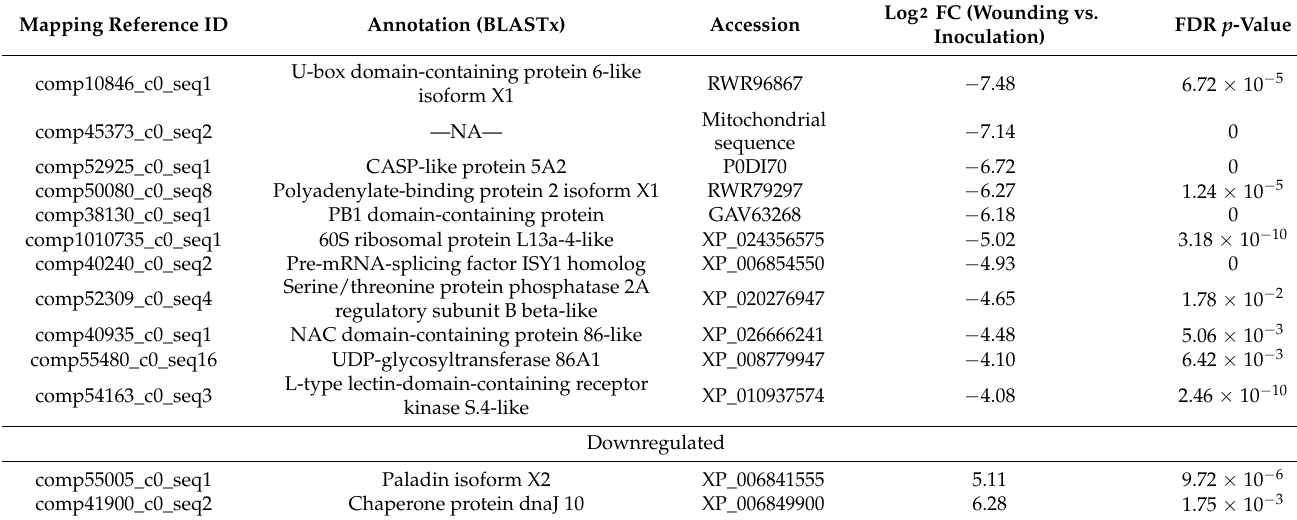
Table 7. Eleven most upregulated (10 annotated) and two downregulated genes after inoculation, compared to wounding. Table 3. Eleven (10 annotated) most upregulated transcripts after inoculation (compared to control).